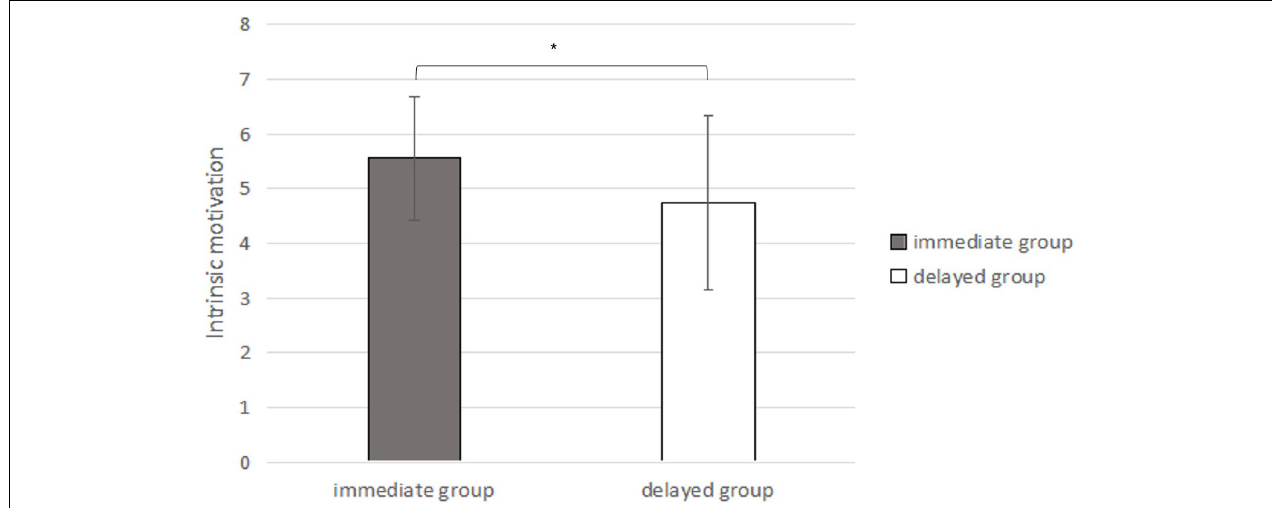
FIGURE 7 | The second IMI scores under the conditions of original immediate extra reward and original delayed extra reward (In the bar graph above, the error bars represent the standard deviations; ∗ represents p < 0.05